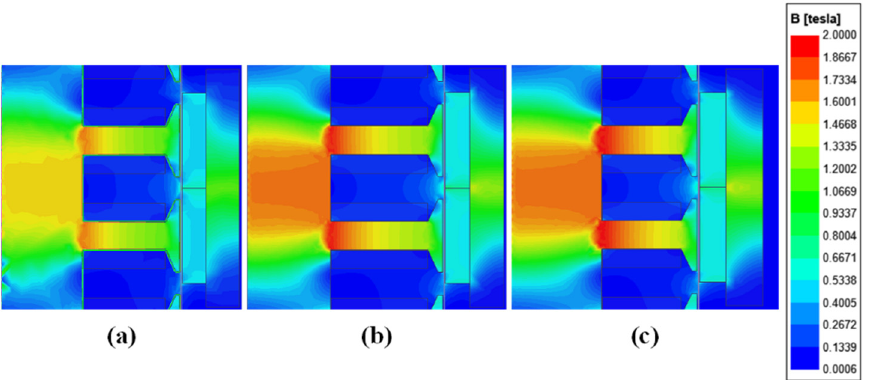
Figure 10. The 2D magnetic flux distribution of the proposed EMLS. ( a ) p m = 15 mm; ( b ) p m = 17.5 mm; ( c ) p m = 20 mm.